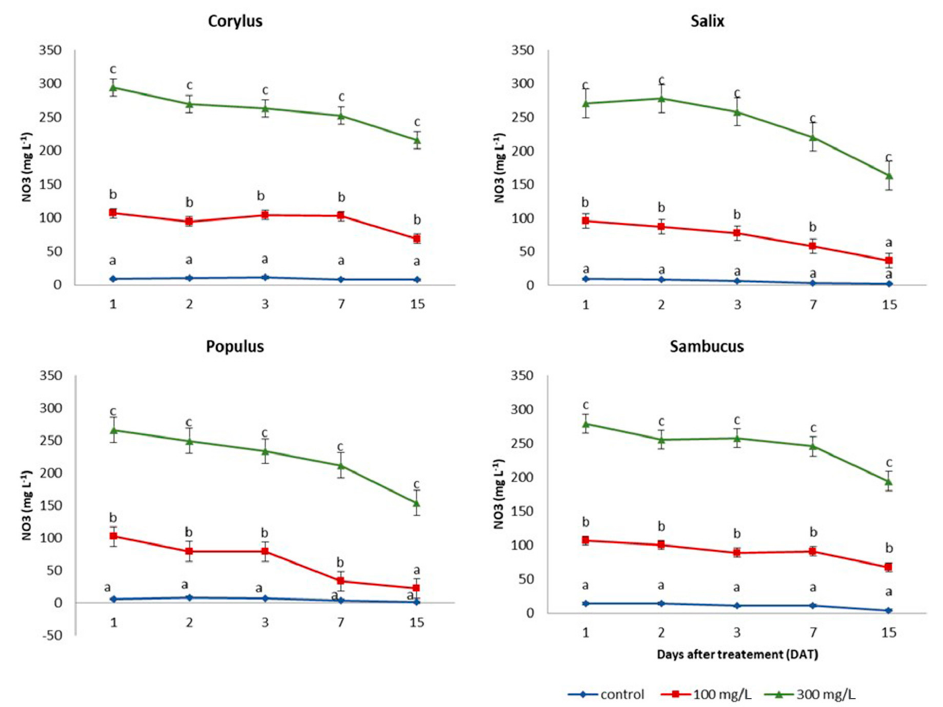
Figure 1. Nitrate concentration of nutrient solutions at 1, 2, 3, 7, and 15 days after treatment (DAT) with NO 3 − in Corylus , Salix , Sambucus and Populus . For each time point and each species, values followed by the different letter are significantly different at p < 0.05.